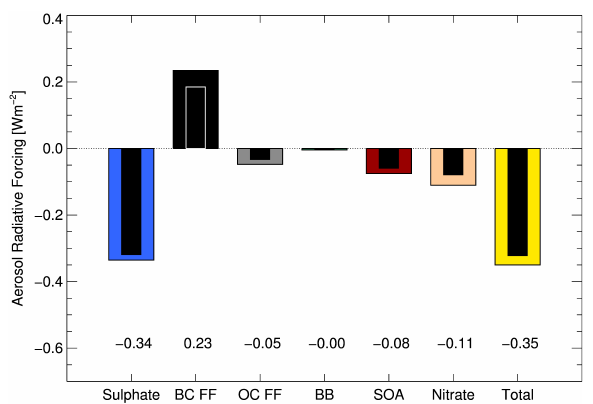
Fig. 17. Model mean RF per component (internal bars), modified from the study timeperiod of 1850–2000 to 1750–2010, based on numbers from Skeie et al. (2011). Details to be given in